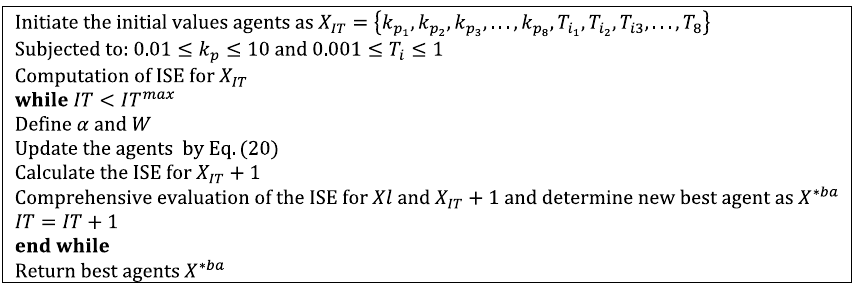
Figure 2. Pseudo-code of the